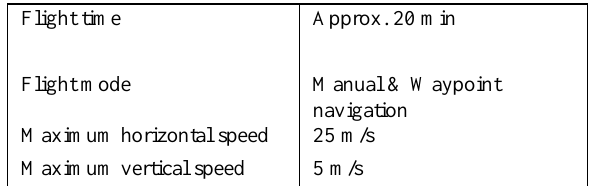
The number of trees were categorized under different classes according to their height. The maximum number of trees (i.e. 43) falls in height class of 20-30m and the least number of trees (i.e. 2) falls in height class of 40-50m (Figure 9).